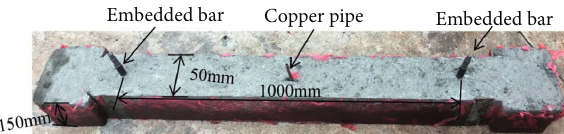
Figure 3: Dimensions of concrete